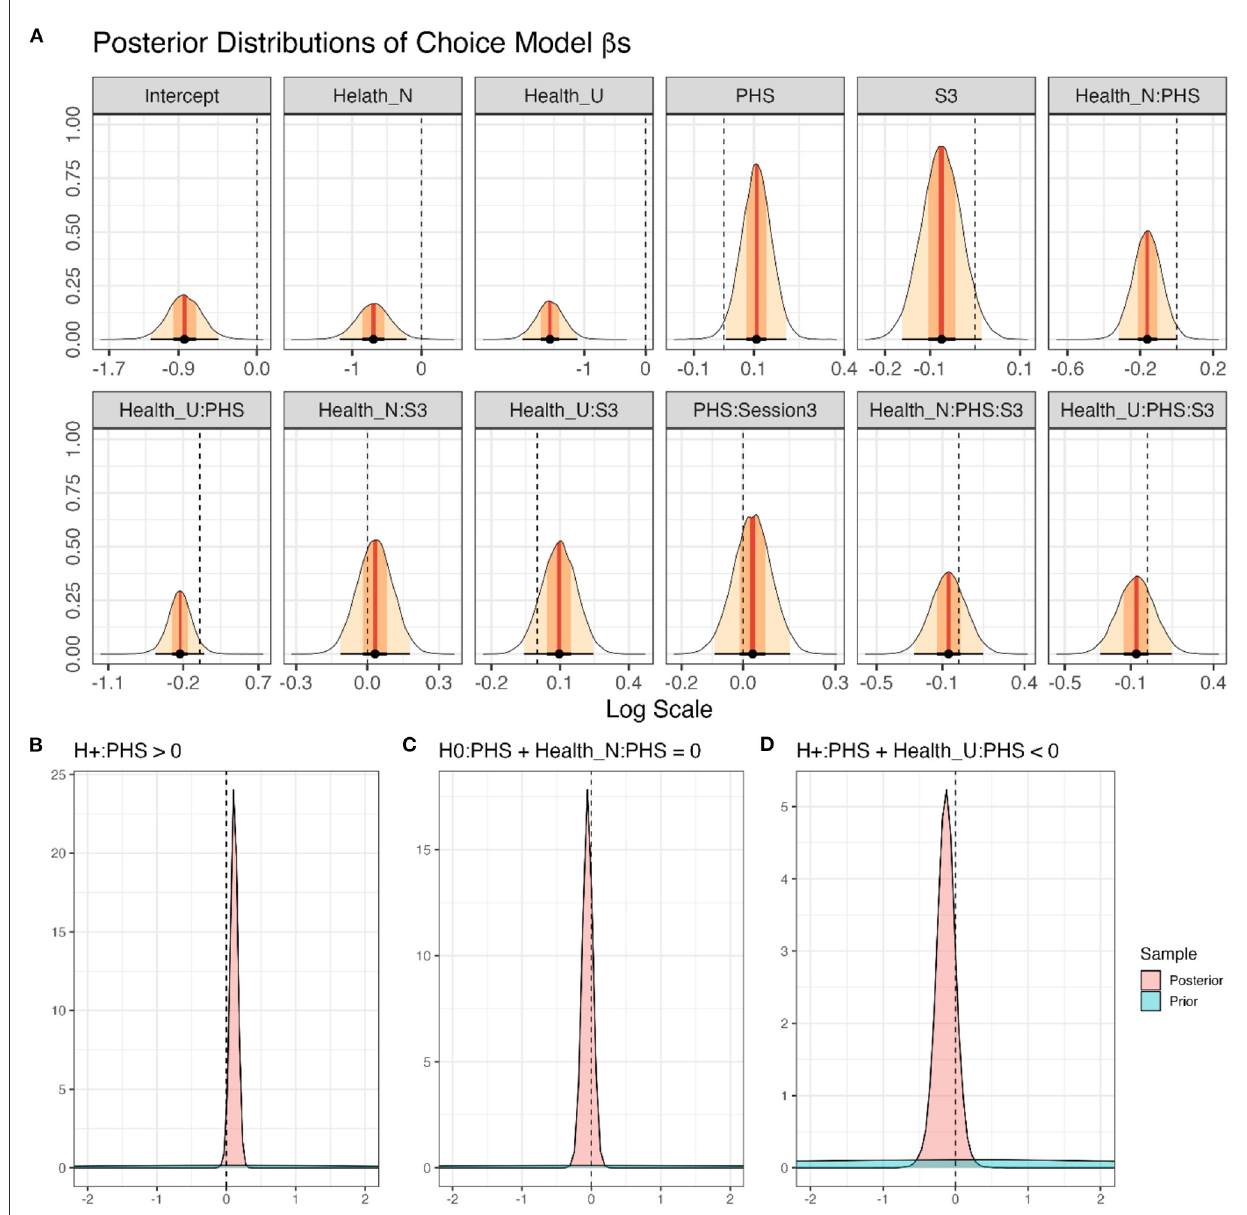
FIGURE5 Modeling of choice performance in the online supermarket task. (A) Density plots of posterior distributions of all β -coefficients included in the full Choice Model (Equation 1); presented values are in log scale. Red lines and orange and yellow shadows represent the mean point estimates and the 50 and 95% highest probability density (HPD) areas, respectively. Please note the different scalings of the X-axes. (B–D) The posterior distributions for specific a priori hypotheses. For more details regarding the hypotheses and results, see the text.